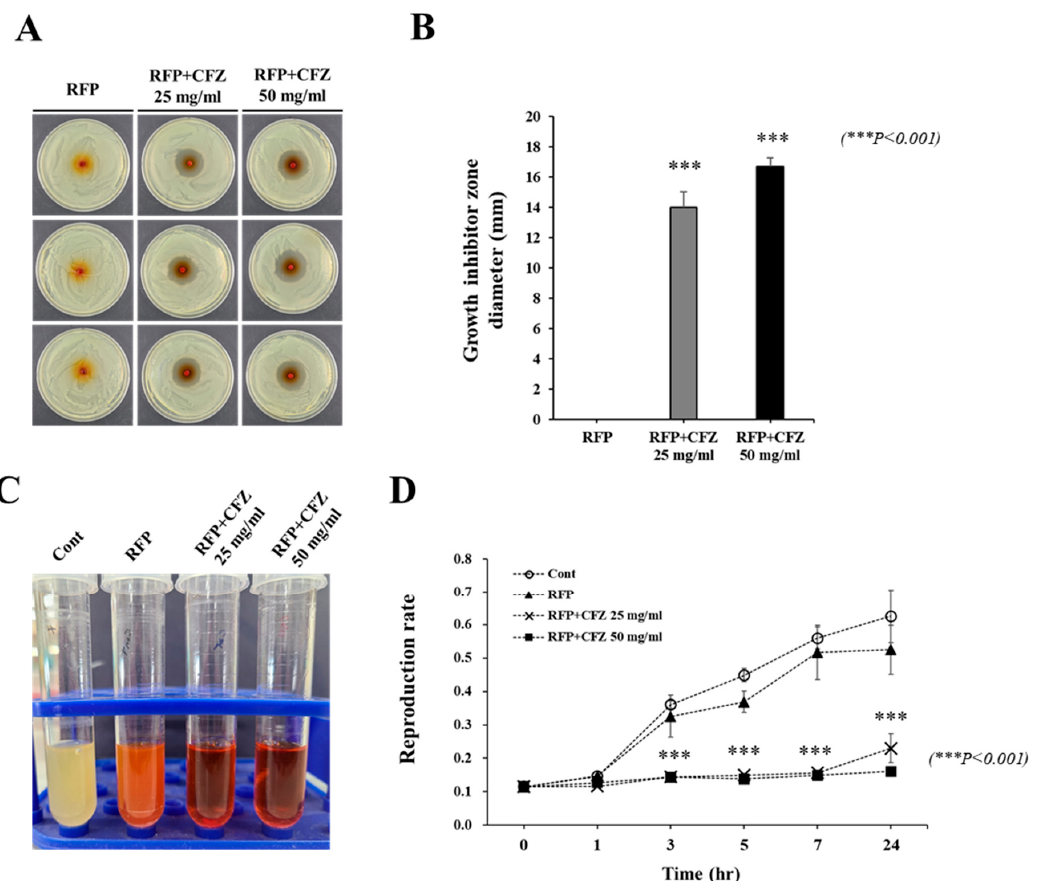
Figure 3. Antibacterial activity of the dual-drug-based scaffold: ( A ) Antibacterial activity of the dual drug-based scaffold in the disk diffusion assay. ( B ) Quantification of growth inhibition zone diameter. ( C ) Antibacterial activity of the dual-drug-based scaffold was assessed by broth dilution assay. ( D ) Bacterial count was monitored at 0, 1, 3, 5, 7 and 24 h after treatment with the dual-drug-based scaffold.